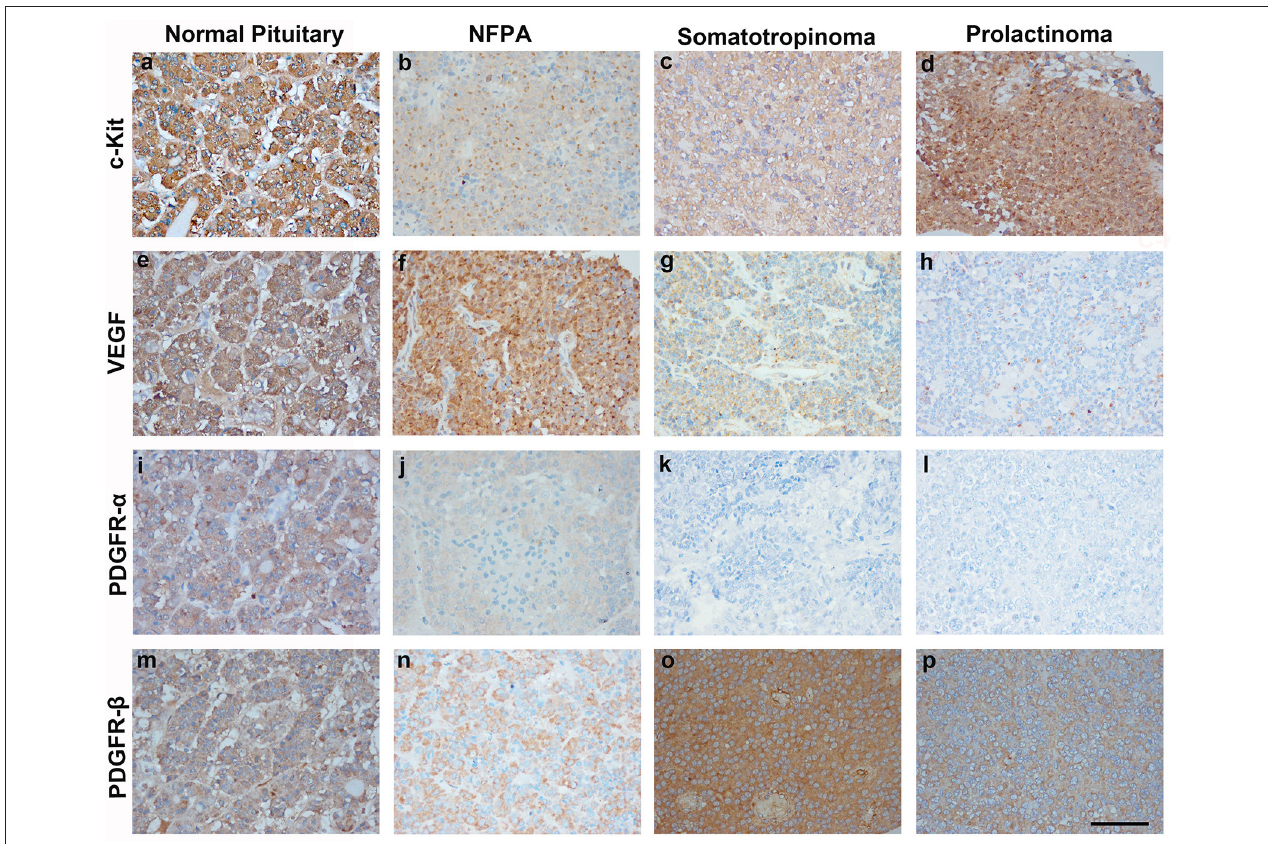
FIGURE 2 | Immunohistochemistry (IHC) of pituitary adenoma shows differential expression of tyrosine kinases (c-kit, VEGF, and PDGFR- α / β ). Cytoplasmic immunopositivity for c-Kit was high in somatotropinoma followed by NFPA, prolactinoma, and normal pituitary (a–d) . Strong cytoplasmic expression for VEGF was observed in NFPA as compared to somatotropinomas, prolactinomas and normal pituitaries (e–h) . PDGFR- α expression was weakly positive in NFPA as compared to normal pituitary while it was negative for somatotropinoma and prolactinomas. (i–l) , PDGFR- β expression was strongly positive in somatotropinomas as compared to normal pituitary while it was weakly positive in NFPA and prolactinomas (m–p) .